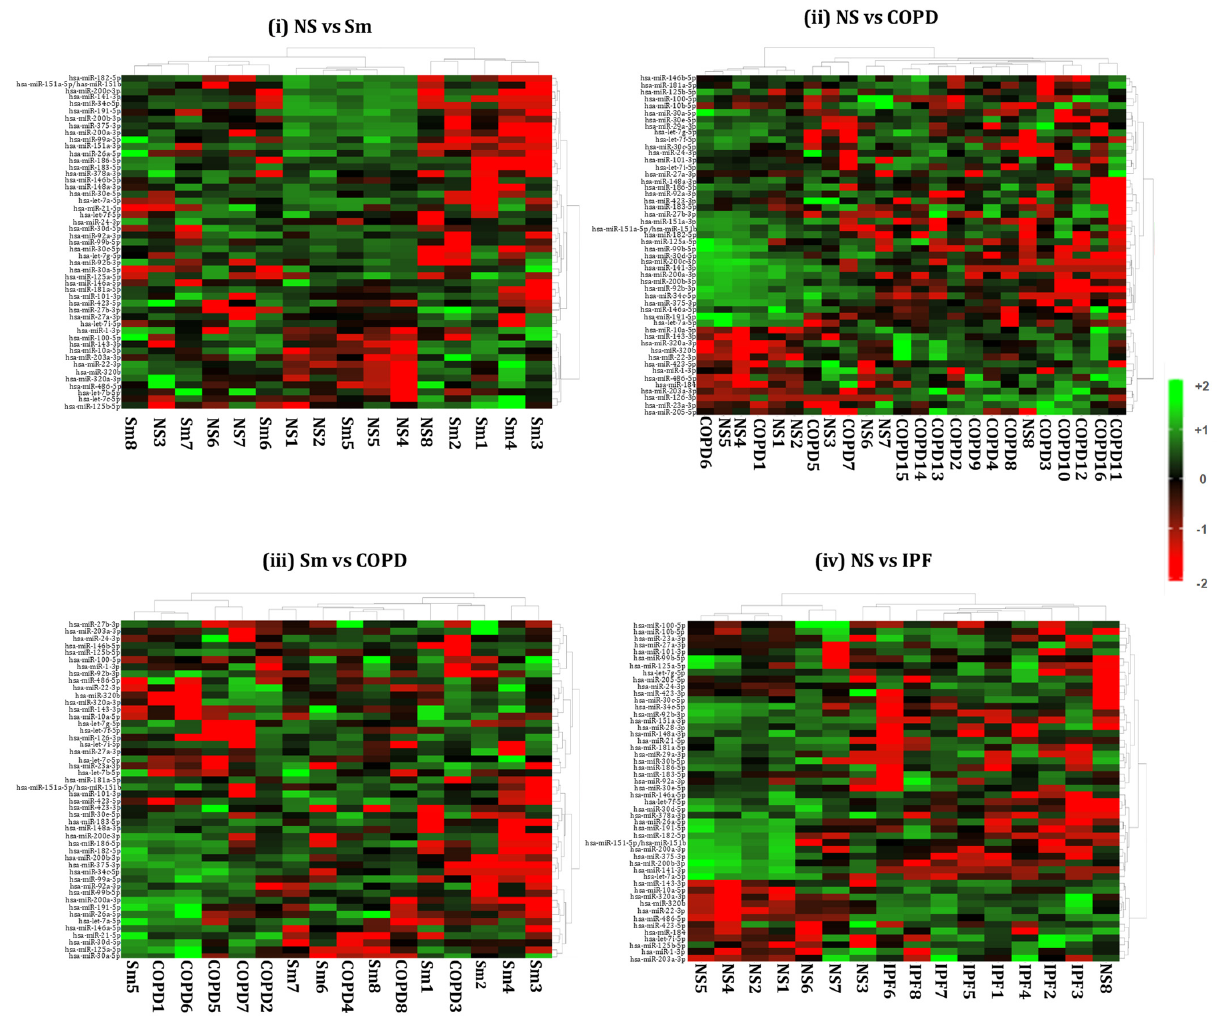
Figure 6. Hierarchical cluster analyses of differentially expressed miRNAs from BALF ‐ derived exosomes. Heat maps showing top 50 variable miRNAs that are differentially expressed in the BALF ‐ derived exosomes from ( i ) healthy non ‐ smokers (NS) vs. healthy smokers (Sm), ( ii ) healthy non ‐ smokers (NS) vs. COPD patients (COPD), ( iii ) healthy smokers (Sm) vs. COPD patients (COPD), and ( iv ) healthy non ‐ smokers (NS) vs. IPF patients (IPF).